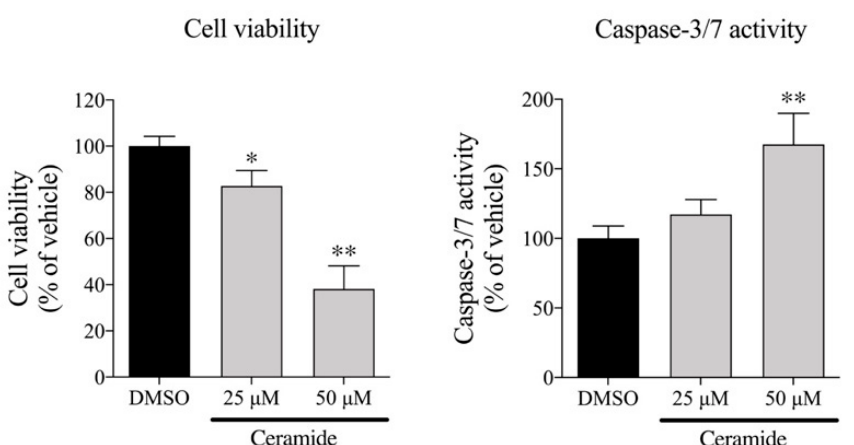
Figure 8. Effects of ceramide on cell viability and caspase-3/7 activity in MIA PaCa-2 cells ( n = 4). Cells incubated with 25 and 50 µM ceramide for 12 h; then, cell number and caspase-3/7 activity were measured. Results calculated as 100% of findings in vehicle control (DMSO); * p < 0.05 and ** p < 0.01 for one-way ANOVA with Dunnett’s multiple-comparisons test compared to vehicle control (DMSO).